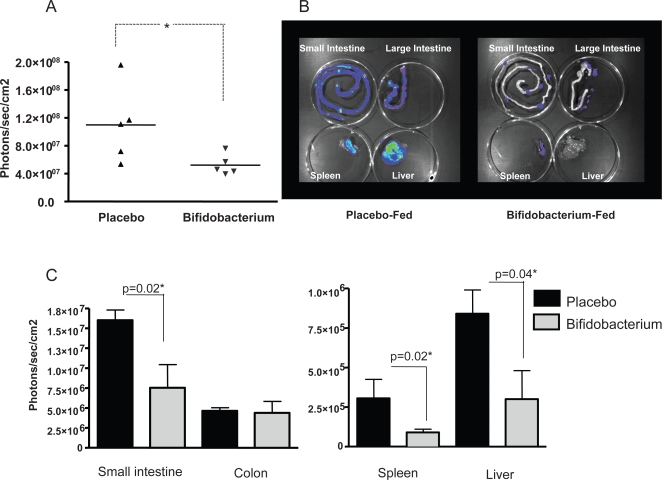
NF-κB activation is suppressed in LPS-injected mice when pre-treated with B. infantis.(A) Whole body imaging of NF-κBlux mice 4 hours following LPS injection reveals suppressed NF-κB activation in the B. infantis-fed animals. (B) Organs were removed for imaging purposes and a representative image is illustrated. (C) The mean increase in NF-κB activation following i.p. injection of LPS is significantly less in the ileum, spleen and liver of B. infantis-fed mice. *p<0.05 versus placebo, n = 5/group.